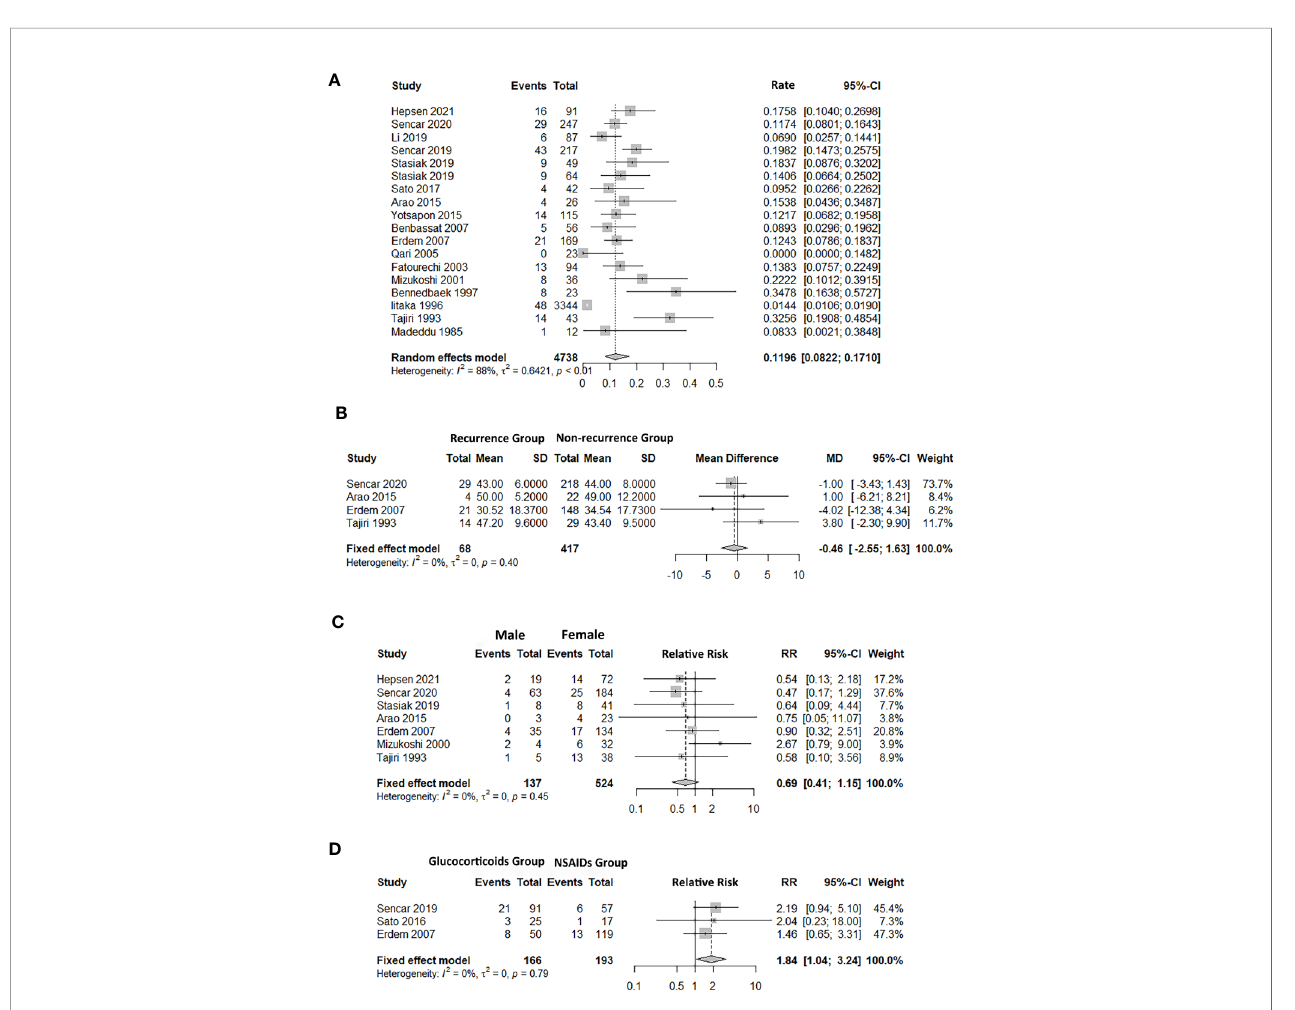
FIGURE 2 | Forest plot of SAT recurrence rate and the association between factors and subacute thyroiditis (SAT) recurrence. (A) recurrence rate. (B) age. (C) sex. (D) treatment (glucocorticoids/NSAIDs). 95% CI, con fi dence